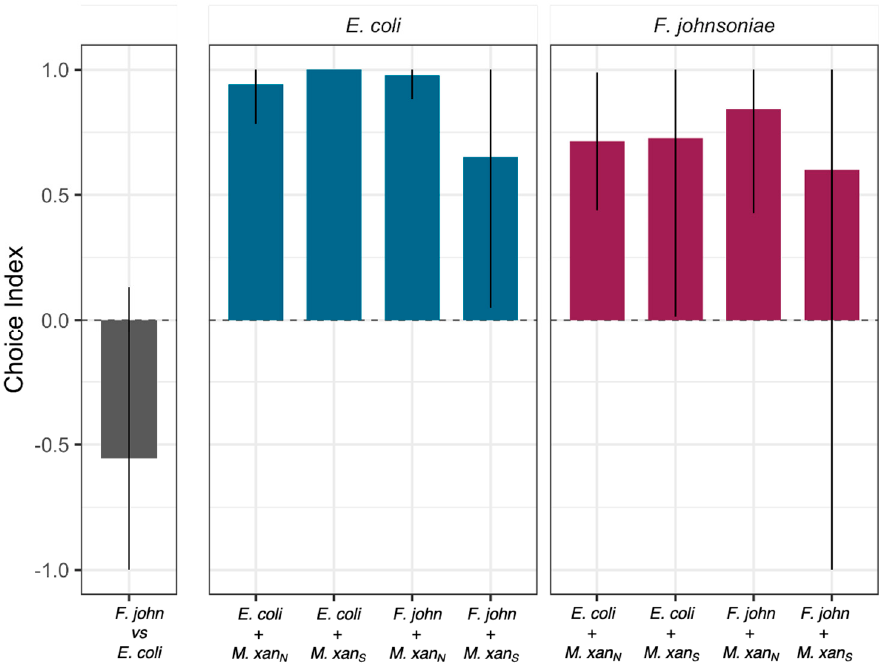
Figure 4. Choice indices for circular patches of basal prey. The leftmost section shows the prefe- rence of C. elegans for E. coli over F. johnsoniae . The next two sections show the choice of the worms between a mono-species patch of basal prey (indicated above the panel, E. coli = blue or F. johnsoniae = red) and a second patch (indicated on the x -axis) consisting of basal prey mixed with M. xanthus either strain S or strain N. Bars are means from three biological replicates and error bars are 95% confidence intervals. For the choice E. coli/E. coli + M. xan S the error bar is zero. In some instances, 95% con fi dence intervals extend outside the range of what is biologically possible, [ − 1,1], so we restricted them to reflect the biological reality. ‘ F. john ’ = F. johnsoniae , ‘ M.xan N ’, ‘ M.xan S ’ = M. xanthus strains N and S, respectively.